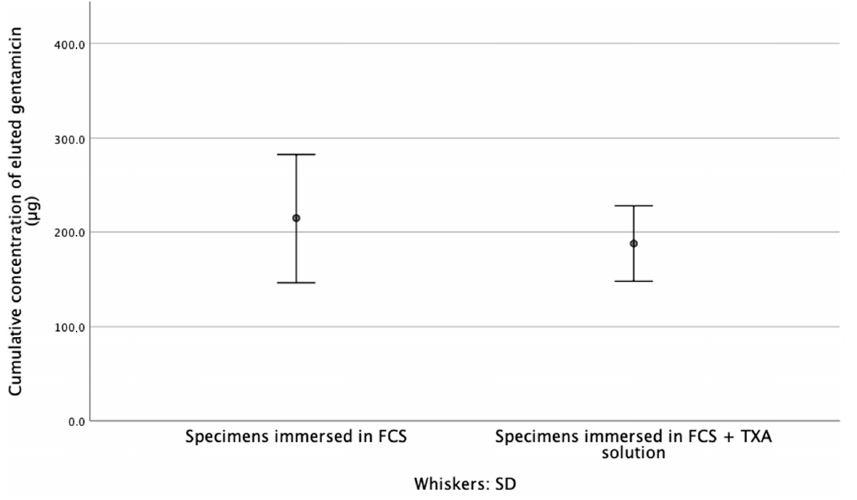
Figure 2. Summary of cumulative released gentamicin concentration results after 7 d of the elution test. After 7 d of immersion in either FCS or FCS + TAX solution, gentamicin was still highly active, with clearly visible ZOI > 20 mm (Figure 3). At this timepoint, the difference in ZOI between the two sets of specimens was not significant ( p = 0.631) (Figure 4).